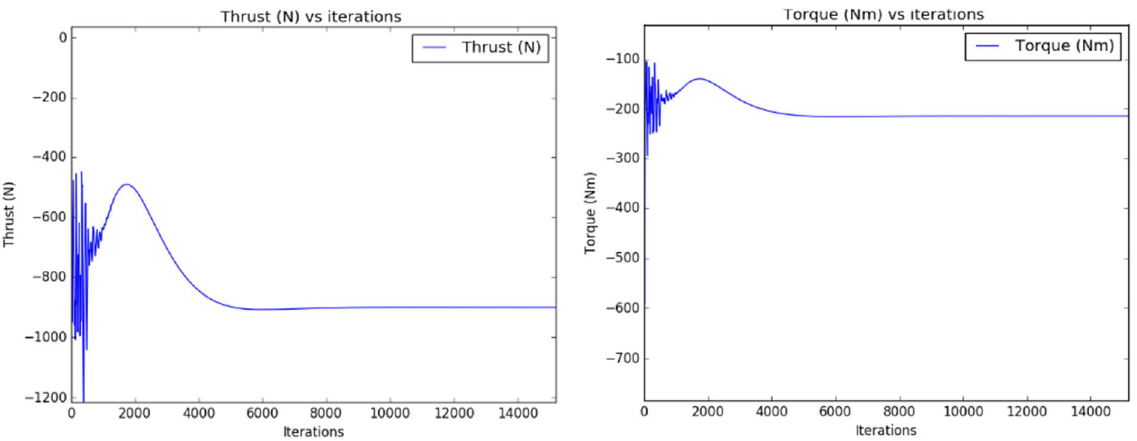
Figure 9. A 2-bladed solo propeller 3D blade shape with a typical domain showing convergence by tracking thrust and torque values.